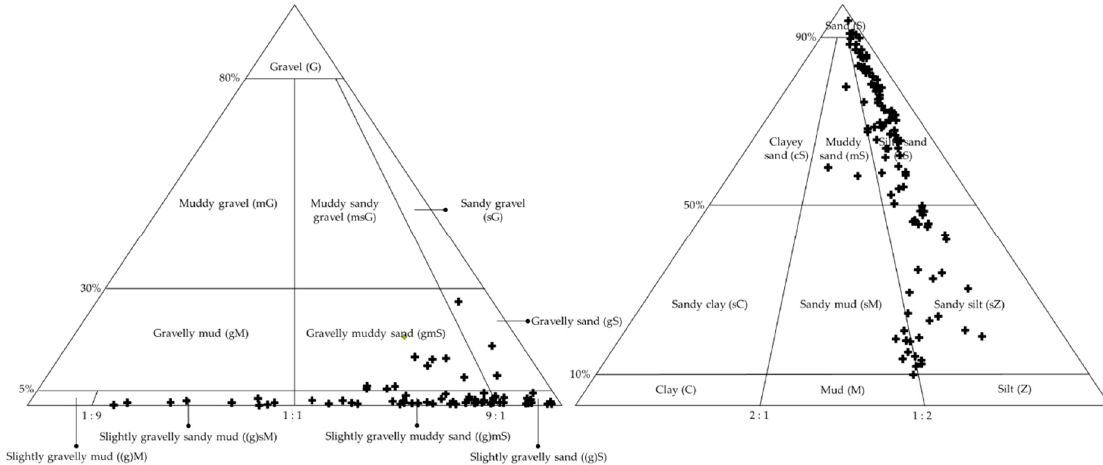
Figure 4. Analysis of grain size using the 232 samples acquired from a field survey, based on Folk’s classification. This diagram shows that sediments consist of gravelly sand (gS), slightly gravelly sand ((g)S, sand (S), gravelly muddy sand (gmS), slightly gravelly muddy sand ((g)mS), silty sand (zS), muddy sand (mS), sandy silt (sZ), slightly gravelly sandy mud ((g)sM), and sandy mud (sM).